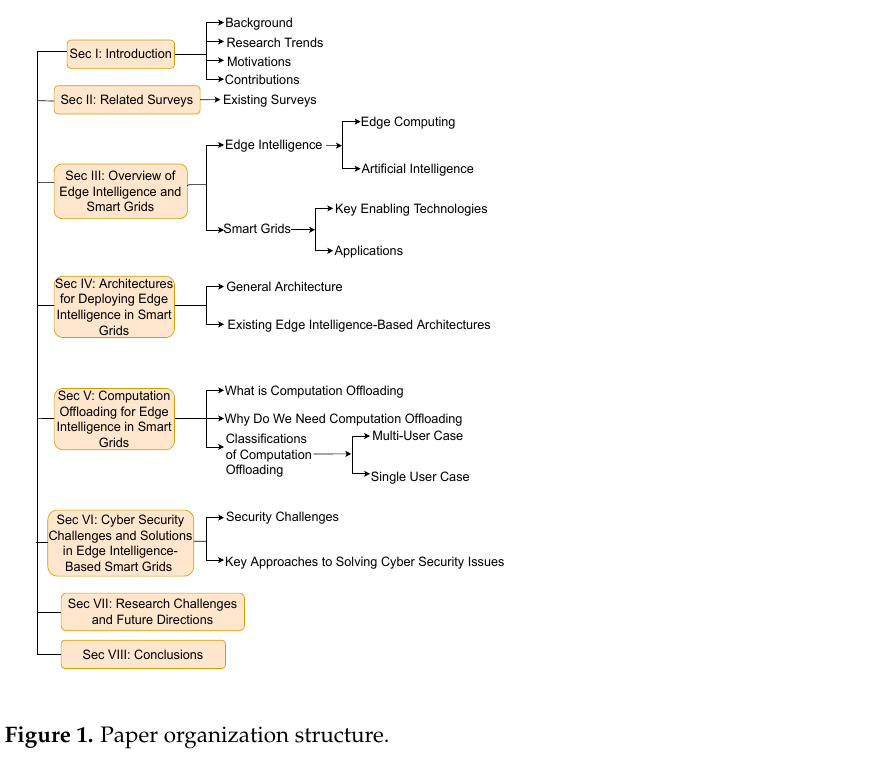
Figure 1. Paper organization